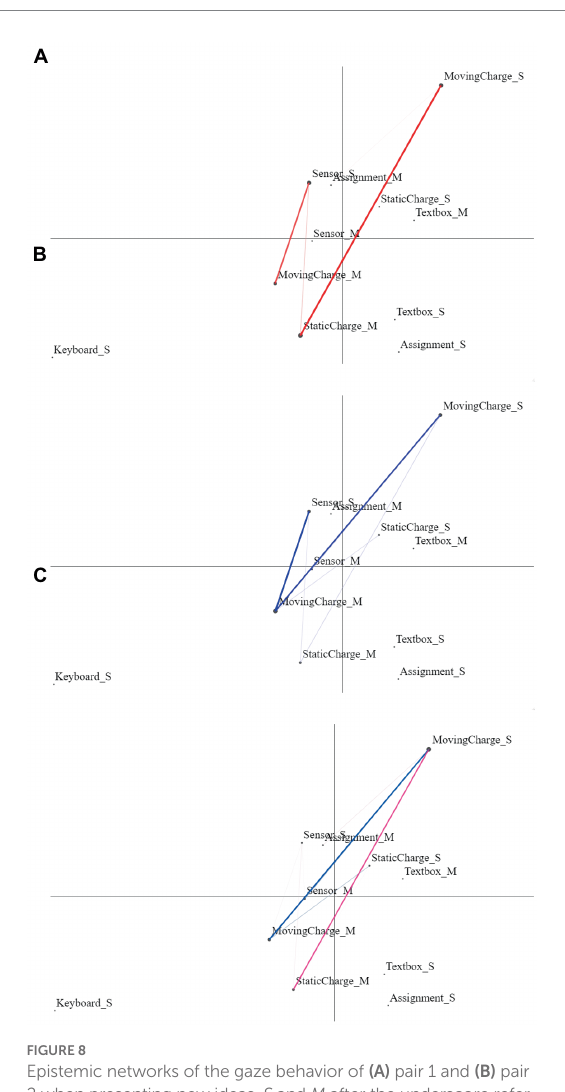
FIGURE 9 Epistemic networks of the gaze behavior of (A) pair 1 and (B) pair 2 during explication. S and M after the underscore refer to the gaze of the sharing student (1S/2S) and the monitoring student (1M/2M). The difference between epistemic networks (A,B) is presented in (C) . The red edges show the connections between the nodes that were stronger among pair 1 than among pair 2. The blue edges show the connections between the nodes that were weaker among pair 1 than among pair